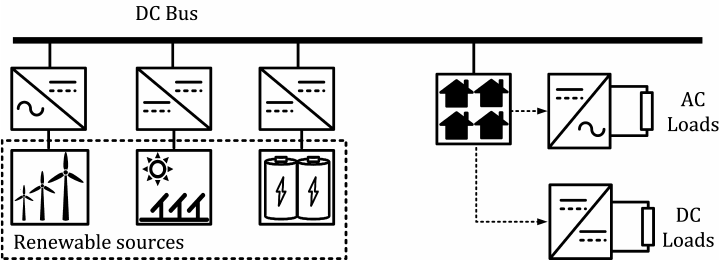
Figure 3. DC microgrid illustration.